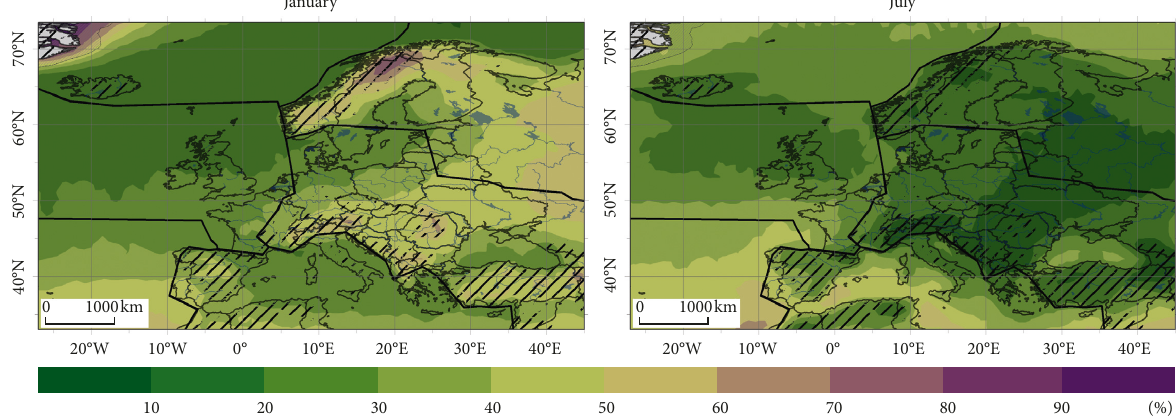
Figure 4: Frequency (%) of humidity inversion occurrence (1981–2015); slanted lines are used to denote areas situated above the average 950hPa level.